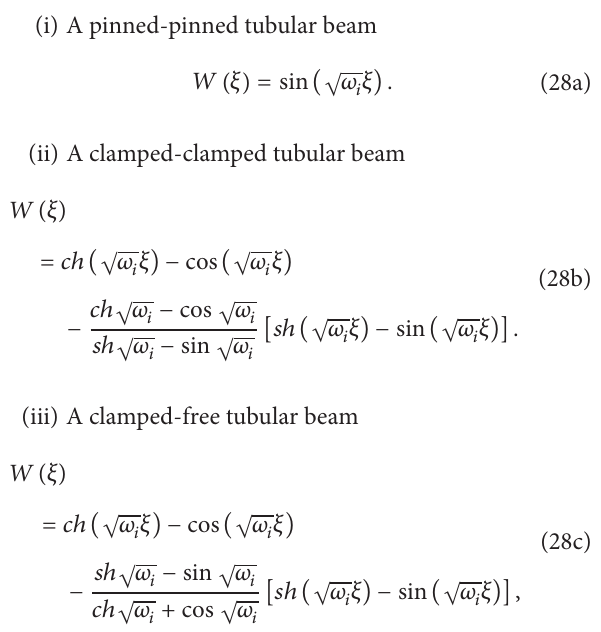
beam with several typical boundary conditions are obtained at 𝑐 = 0 as